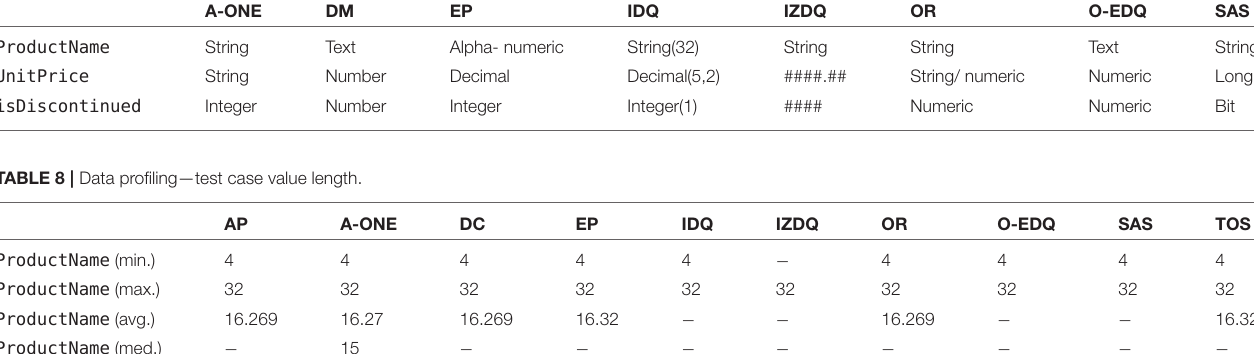
TABLE 7 | Data profiling—test cases basic types. A-ONE DM EP IDQ IZDQ OR O-EDQ SAS String Text Alpha- numeric String(32) String String Text String UnitPrice String Number Decimal